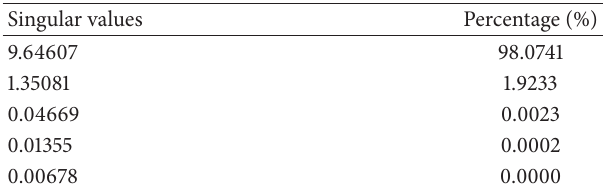
Figure 1: The first three 𝑈 component spectra in sequence: solid, dashed,anddottedlinesfortheSVDofbindingofAct-D-DNAspec- trophotometric titration data. Table 1: The first five singular values ( S matrix principal compo- nents) for ActD-DNA spectrophotometric titration